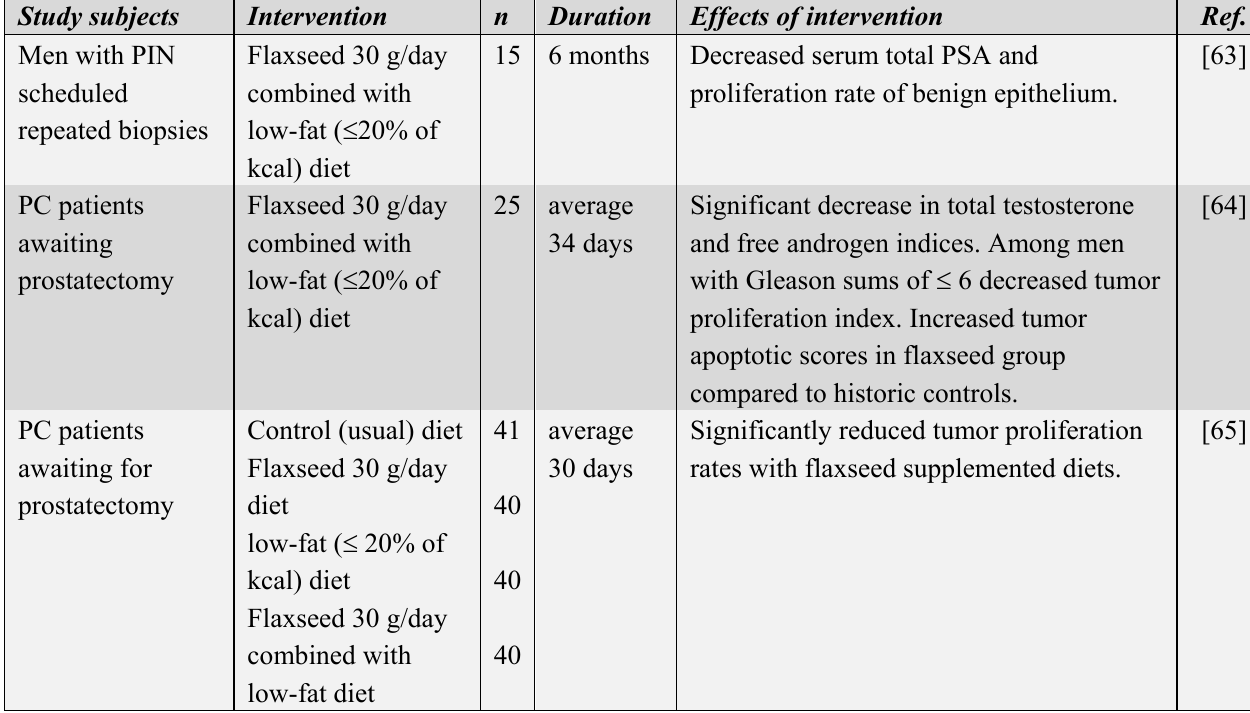
Table 2. Summary of the intervention studies performed with lignan-rich flaxseed on prostate